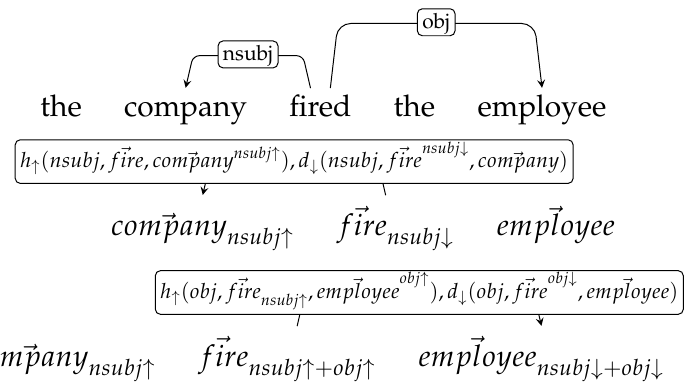
Figure 1. Dependency-based analysis of the company fired the employee and left-to-right interpretation process to build the contextualized word senses of the three lexical constituents.